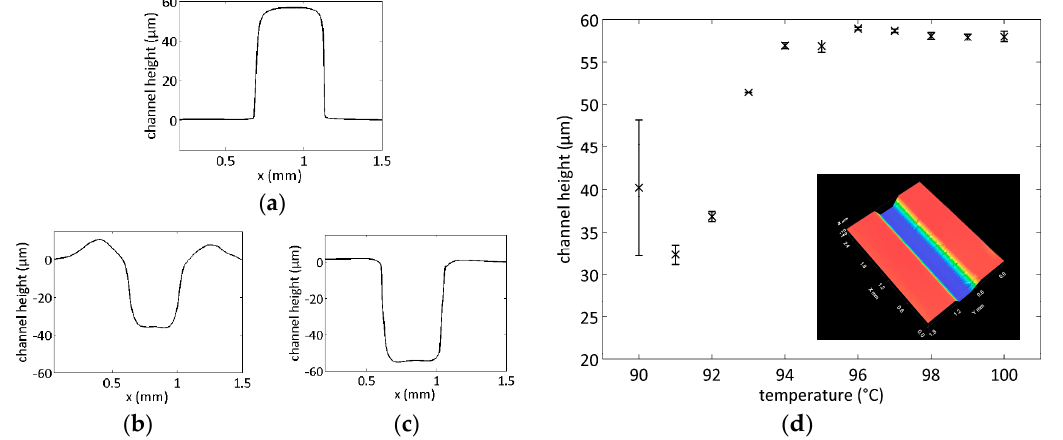
Figure 2. Height profile of the epoxy structure ( a ) and the embossed PS channels using cylinder temperatures of 91 °C ( b ) and 96 °C ( c ). The dependence of the channel depth on the cylinders’ temperature is given in ( d ), the white light interferometer scan of 1.8 × 2.4 mm 2 of the 96 °C-channel in the inset shows the good regularity of the embossed channels.